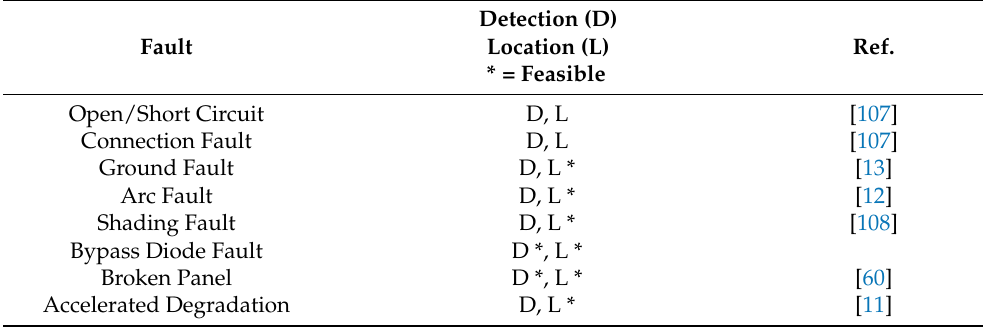
Table 1. Overview of the SSTDR technique for fault detection and location. a “D” or “L” indicate the method has been demonstrated for detection or location, respectively. * means it is feasible that the method could be used, but it has not been demonstrated from